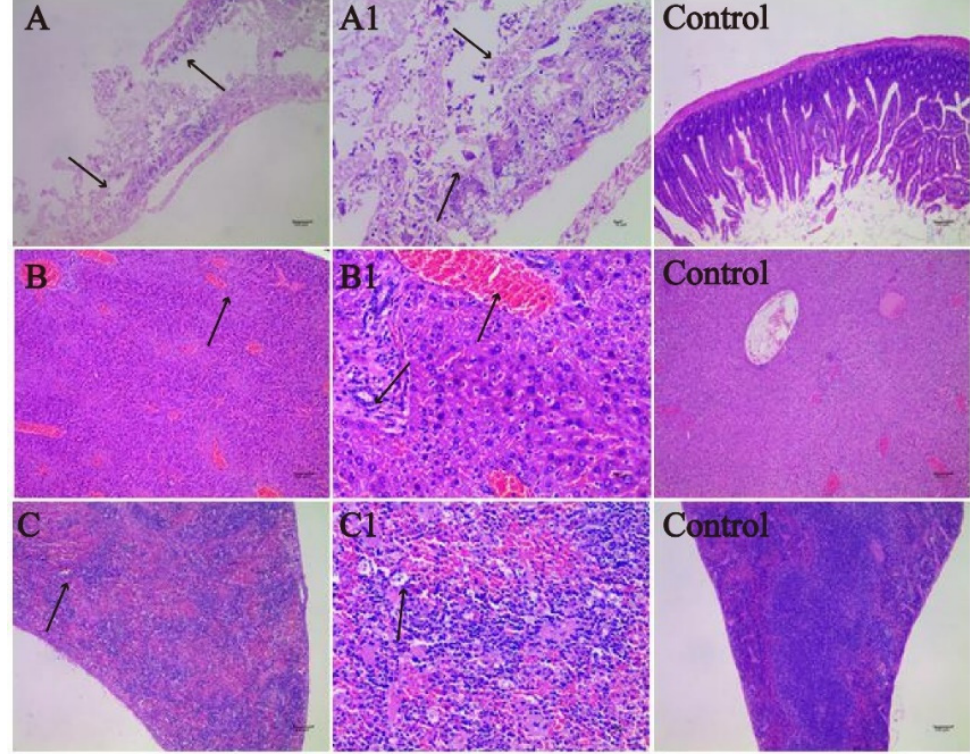
Figure 5. Histological lesions in the spleen, liver, and intestines of KM mice. ( A ) (100 × intestine)/( A1 ) (400 × intestine): the structure of intestines was destroyed, pointed to by the arrows in ( A )/( A1 ); ( B ) (100 × liver)/( B1 ) (400 × liver): heterogeneous cytoplasmic staining results in the empty reticular structure, pointed to by the arrows in ( B )/( B1 ); ( C ) (100 × spleen)/( C1 ) (400 × spleen): nucleolysis was observed, pointed to by the arrows in ( C )/( C1 ). Scale bar: 100 µ m (( A – C ) and the Control group); 10 μ m ( A1 – C1 ).